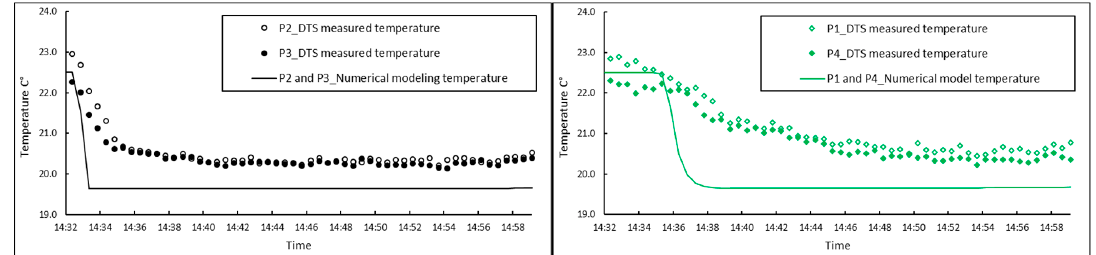
Figure 10. Measured temperature by the optical fiber DTS and the calculated temperature by the numerical modeling. The results are presented for all 12 measuring points. Points are located in figures based on their location at the experimental model.